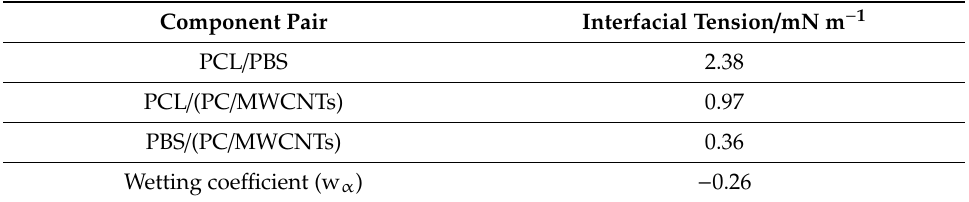
Table 4. Interfacial tensions and wetting coe ffi cient of the investigated